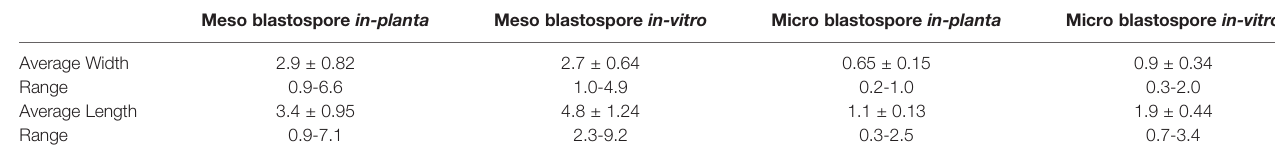
TABLE 1 | Spore dimensions (µm) of two types of blastospores: meso-blastospores and micro-blastospores. Meso blastospore in-planta Meso blastospore in-vitro Micro blastospore